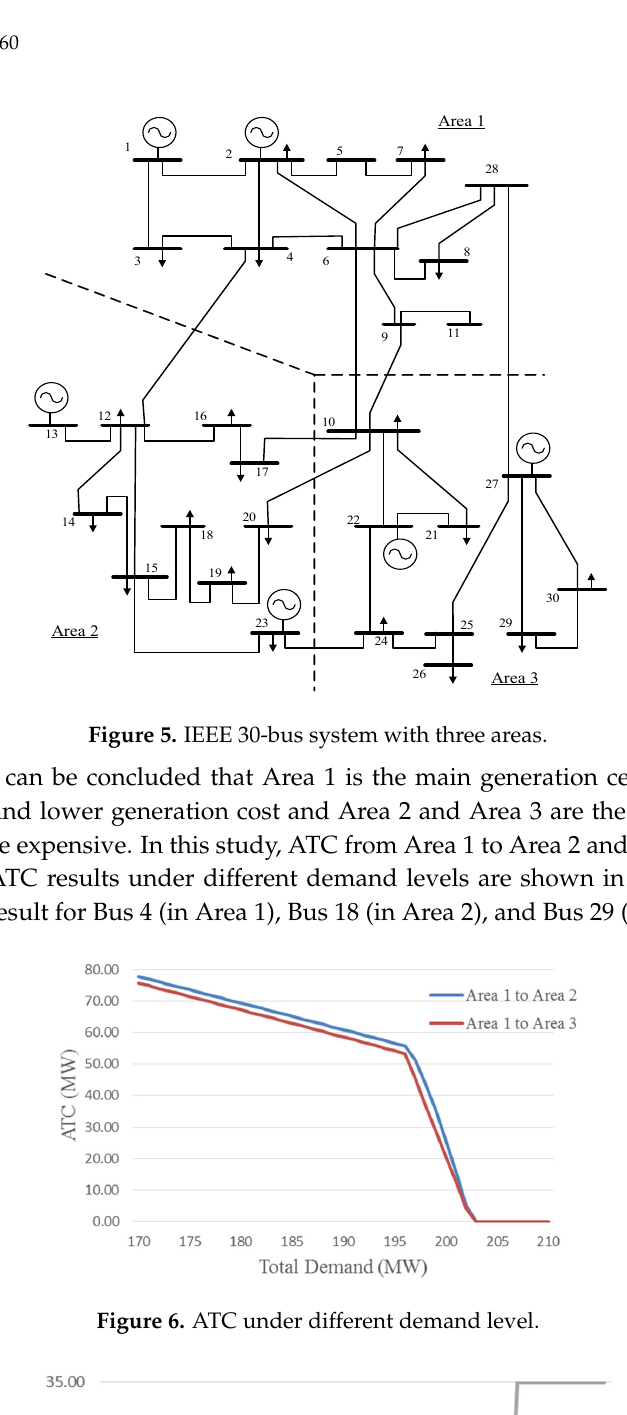
Figure 6. ATC under different demand level. Table 5. ATC and ED results of IEEE 30 ‐ bus system under different demand level.